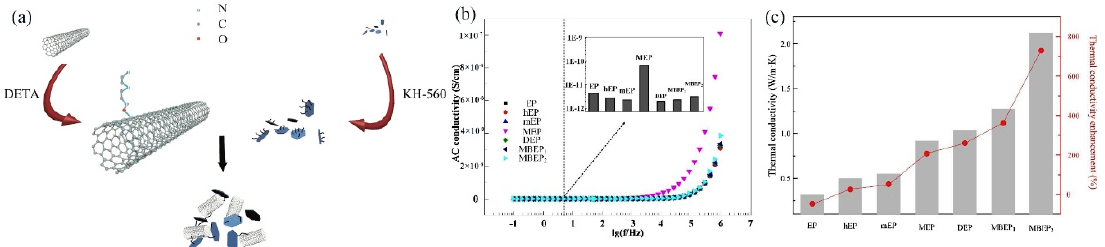
Figure 7. ( a ) Preparation process and principle of high-thermal-conductivity epoxy resin. ( b ) Alternating-current (AC) conductivity of the epoxy nanocomposites. ( c ) λ of pure epoxy and its nanocomposites with different nanofillers (reproduced with permission from [124]).